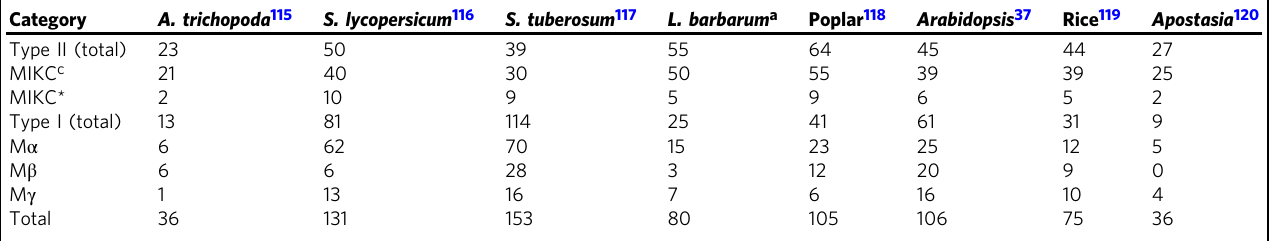
Table 1 MADS-box genes in A. trichopoda , S. lycopersicum, S. tuberosum, L. barbarum , poplar, Arabidopsis , rice, and orchid Apostasia